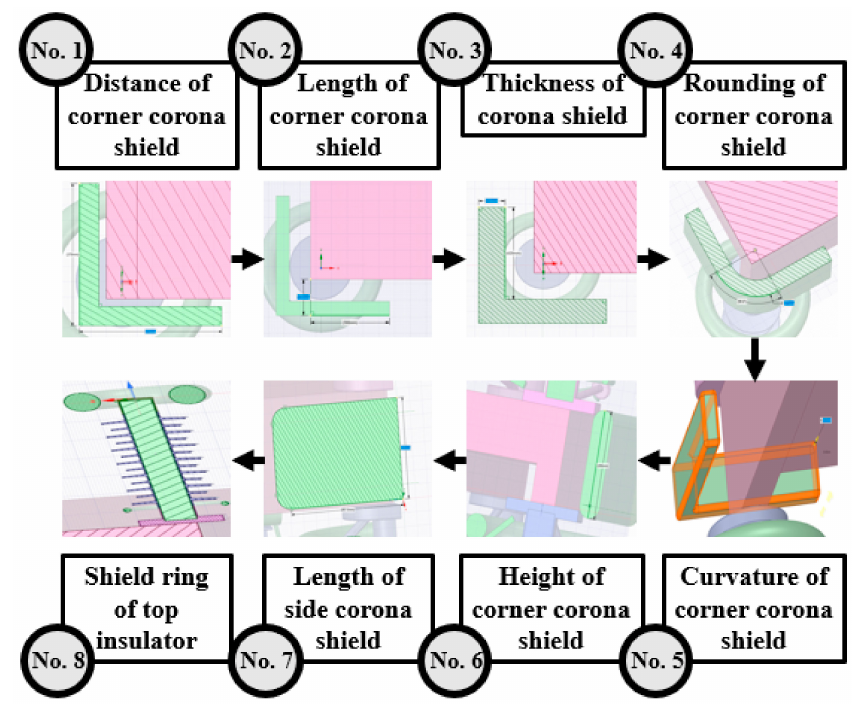
Figure 11. DC corona shield design process considering the design